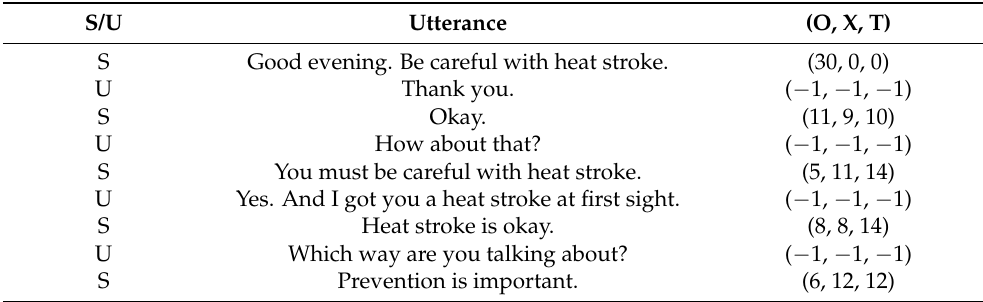
Table 1. Example of the dialogue with dialogue breakdown labels.